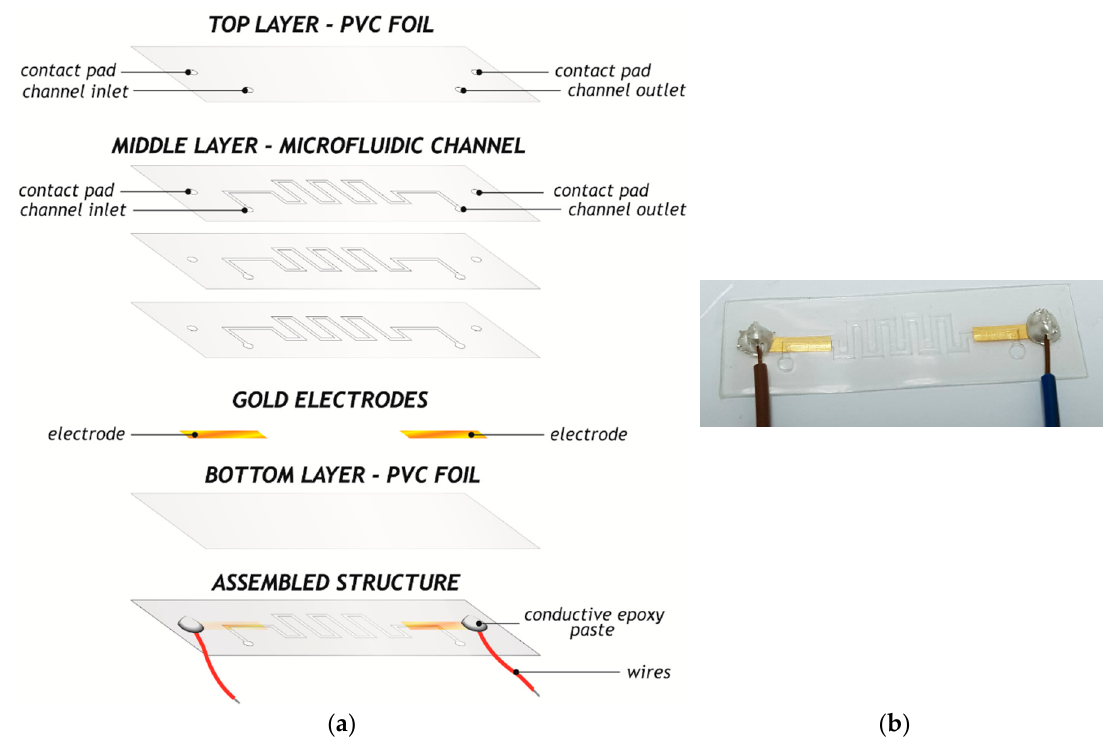
Figure 2. ( a ) Design of multi-layered resistor: bottom—PVC layer with gold electrodes, middle layer—microfluidic channel, top layer—for inlet, outlet and electrical terminals, ( b ) one of the fabricated microfluidic resistors, after lamination.